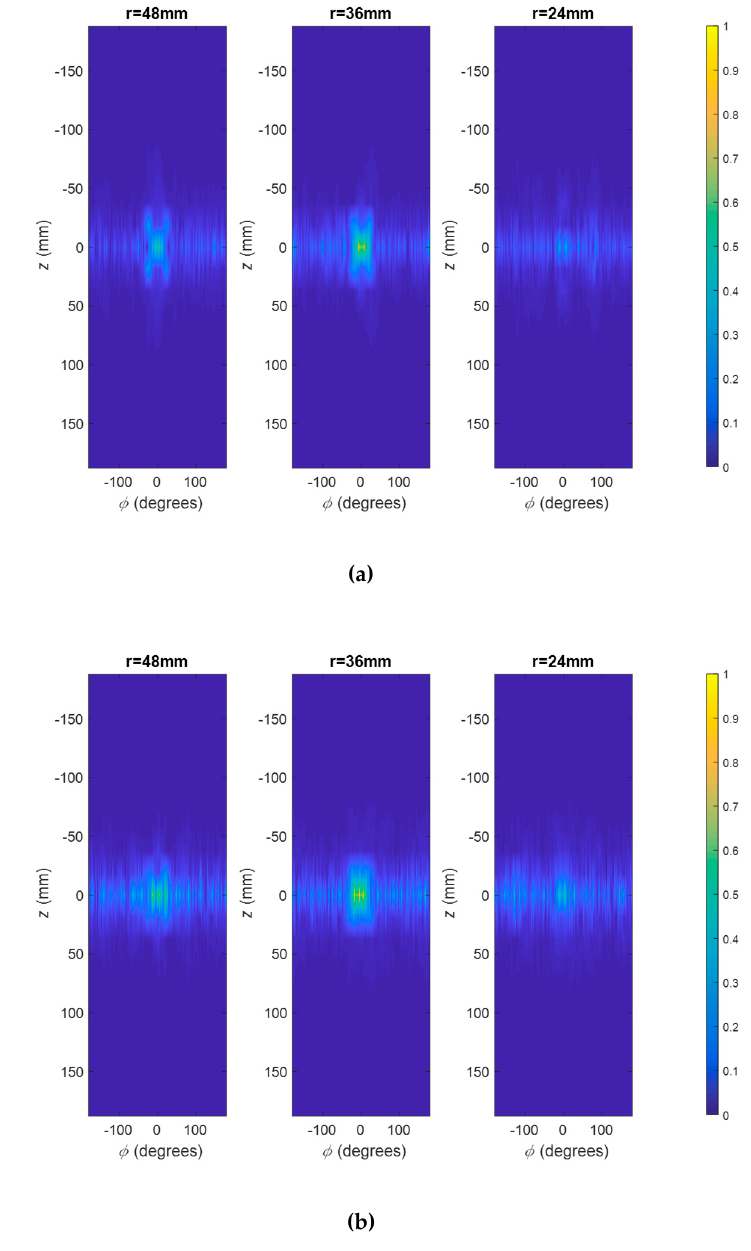
Figure 13. Reconstructed 3D images of the object shown in Figure 11 when the data is corrupted by noise of: ( a ) SNR = 20 dB and ( b ) SNR = 10 dB.